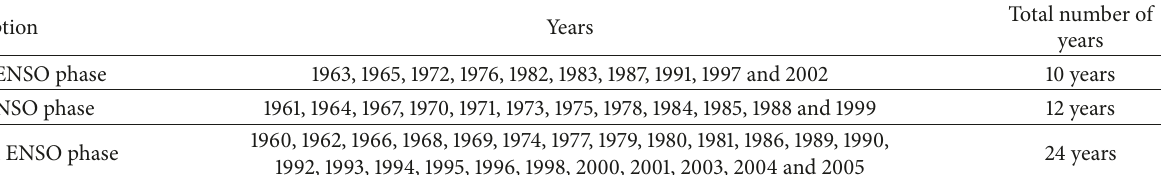
Table 2: List of years for different ENSO phases during JJAS season from 1960 to 2005.